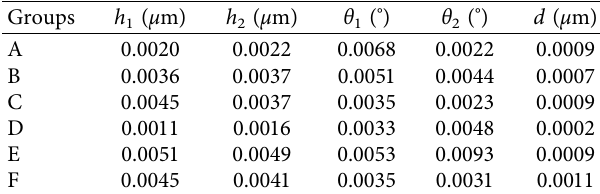
Table 6: Relative errors of precision.